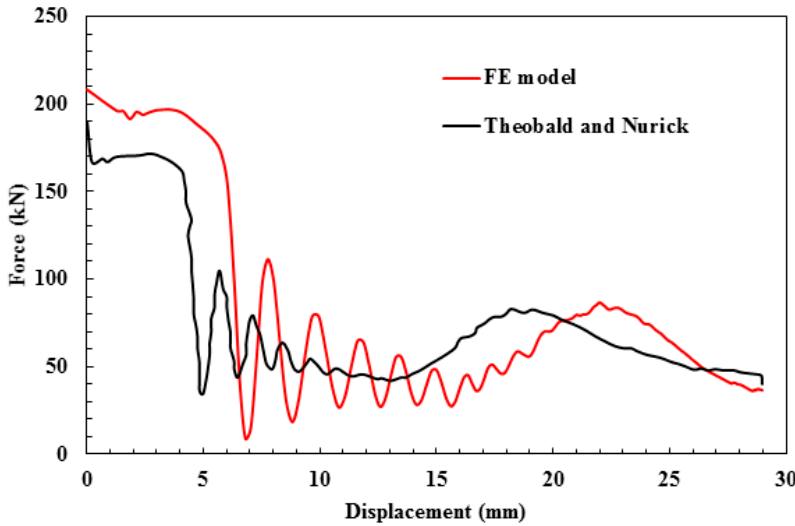
Figure 8. Force-displacement curve of current finite element (FE) model and Theobald and Nurick [7] for a panel of nine core tubes. Table 5. Finite element model validation.